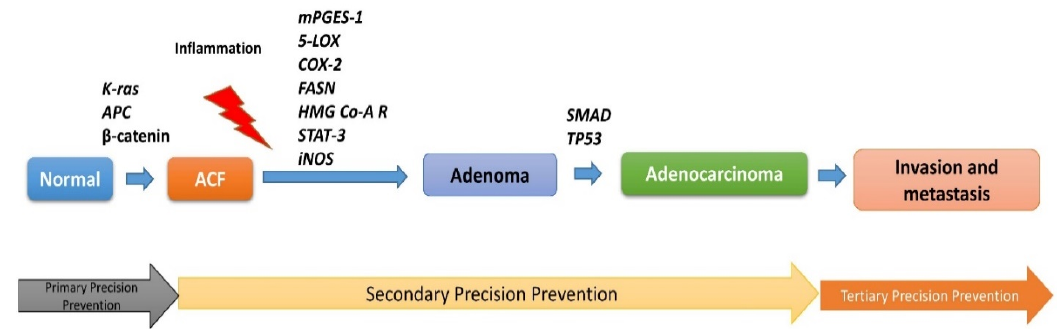
Figure 1. Important molecular targets during colorectal tumorigenesis and progression. Table 1. Expression status of molecular targets at different stages from initiation to progression of colorectal cancer (CRC).